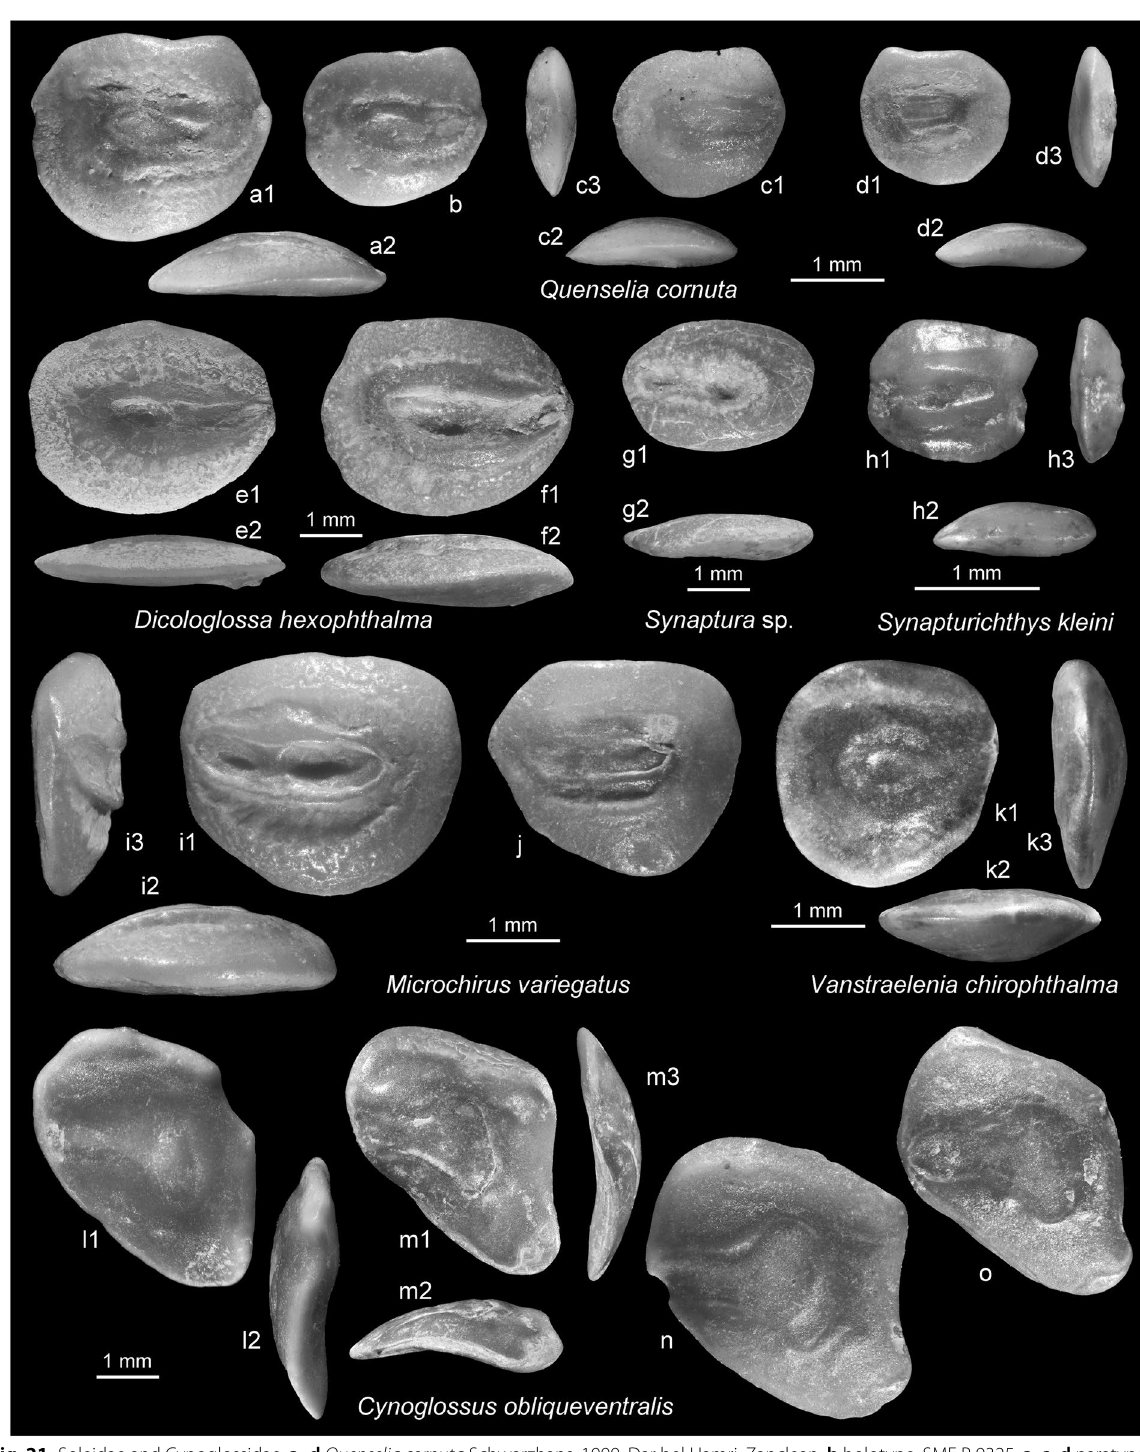
Fig. 21 Soleidae and Cynoglossidae. a – d Quenselia cornuta Schwarzhans, 1999, Dar bel Hamri, Zanclean, b holotype, SMF P 9325, a , c – d paratypes, SMF P 9326. e – f Dicologlossa hexophthalma (Bennett, 1831), f SMF PO 101.232, Dar bel Hamri, e extant, Lagos fish market, Portugal. g Synaptura